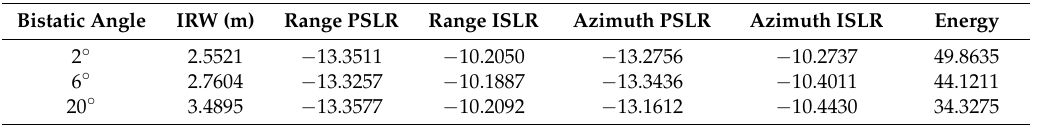
Figure 16. The simulation results for 20° bistatic angle without the consideration of the TCR optimum boresight. ( a ) The point target image after upsampling 48 times; ( b ) the azimuth profile based on the results of the electromagnetic simulation. Table 2. Image quality analysis parameters of the TCR. IRW: impulse response width, PSLR: peak side lode ratio, ISLR: integral side lobe ratio.